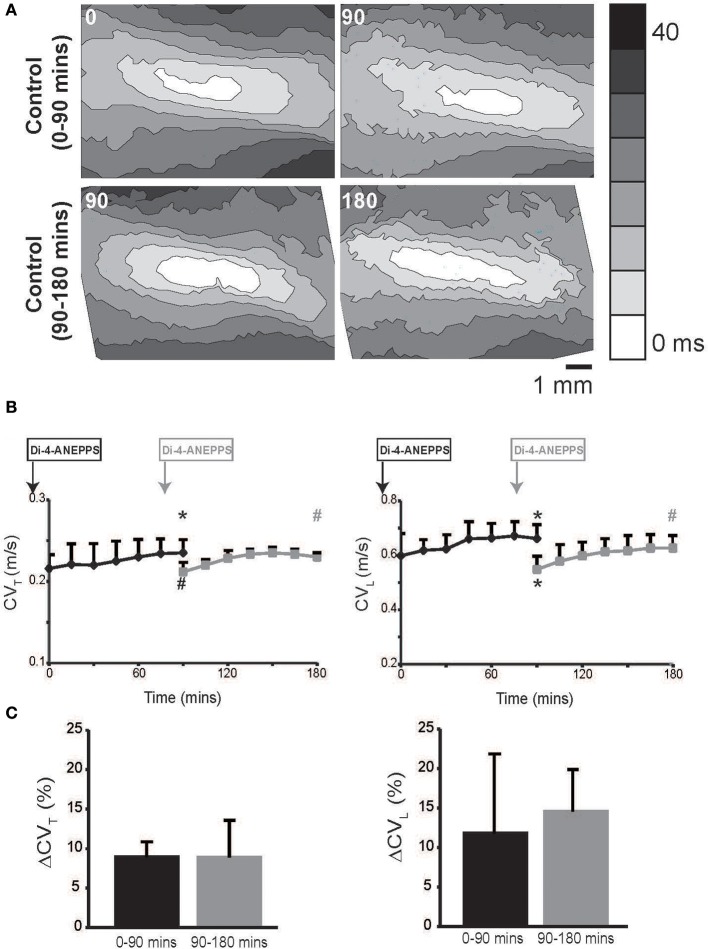
Conduction velocity quantified by optical mapping increases with time. (A) Representative isochrone maps from control Tyrode's solution perfused hearts at 0, 90 and 90, 180 mins. (B) Summary CVL and CVT measured up to 180 mins. Black curves indicate experiments where dye was perfused before t = 0 mins and gray curves indicates experiments where dye was perfused at 75 mins. (C) Percent increase in CVT and CVL over 90 min durations in the two sets of experiments. Black and gray *Indicates p < 0.05 relative to t = 0 or 90 mins respectively by paired comparison. Black # indicates p < 0.1 comparing between black and gray data point at 90 mins. Gray # indicates p < 0.1 comparing gray data point 90 and 180 mins.